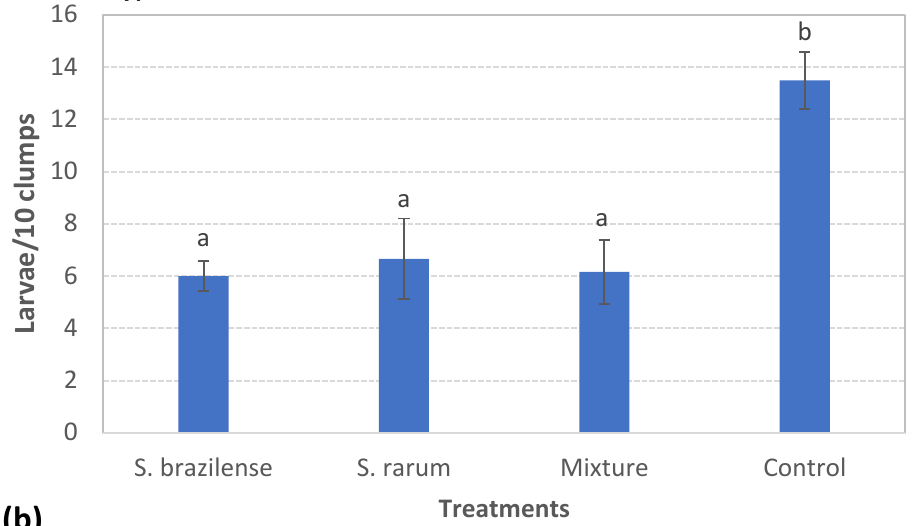
Figure 8. Populations of Sphenophorus levis (larvae + pupae + adults) ( a ) and Hyponeuma taltula (larvae) ( b ) in a sugarcane field, 21 days after the application of Steinernema rarum (2 × 10 8 IJs/ha), S. brazilense (2 × 10 8 IJs/ha), a mixture of both nematodes (total of 2 × 10 8 IJs/ha with each nematode contributing half) and control. Means followed by different letters in the columns differ significantly by the Tukey test ( p < 0.005).